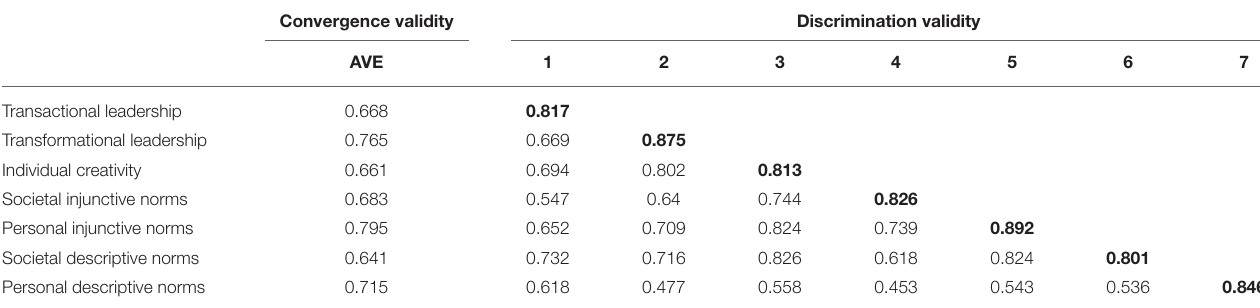
TABLE 3 | Correlation